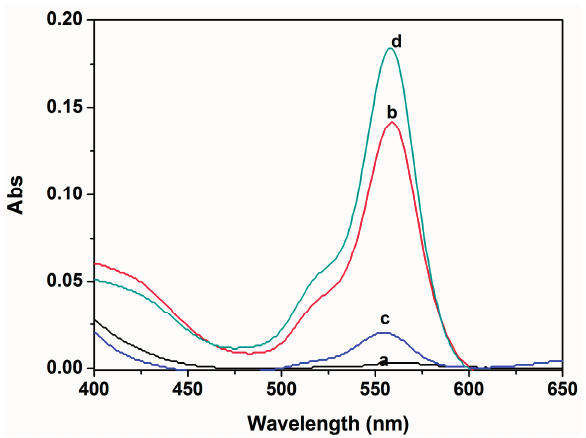
Figure 6. Absorption spectra in ethanol-water solution (9:1, v:v. 20 mM HEPES, pH 7.0): (a) P (10 μ M); (b) P (10 μ M) with Cu 2+ (10 μ M); (c) P (10 μ M ) with Cu 2+ (10 μ M) and then the addition of EDTA (50 μ M); (d) P (10 μ M) with Cu 2+ (10 μ M) and EDTA (50 μ M) and then the addition of 0.1 mM Cu 2+